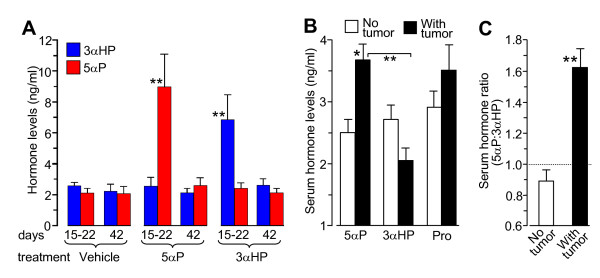
Hormone levels in serum. (A) Serum hormone levels after treatment. Serum samples (n = 4 to 5) were analyzed 15 to 22 days and 42 days after mice received an injection of vehicle (control), 5αP, or 3αHP. Data points represent nanograms per milliliter (mean ± SEM). (**P < 0.01 compared with respective controls). (B) Hormone levels in serum from 10 control (vehicle only) mice, six of which had developed tumors spontaneously (With tumor), and four that remained without tumors (No tumor). Hormone levels were determined with RIA and are presented as nanograms per milliliter 5αP, 3αHP, and progesterone (Pro) and (C) as the ratio of 5αP to 3αHP. *P < 0.05; **P < 0.01 for the comparison, as indicated or versus the levels in the "No tumor" mice.